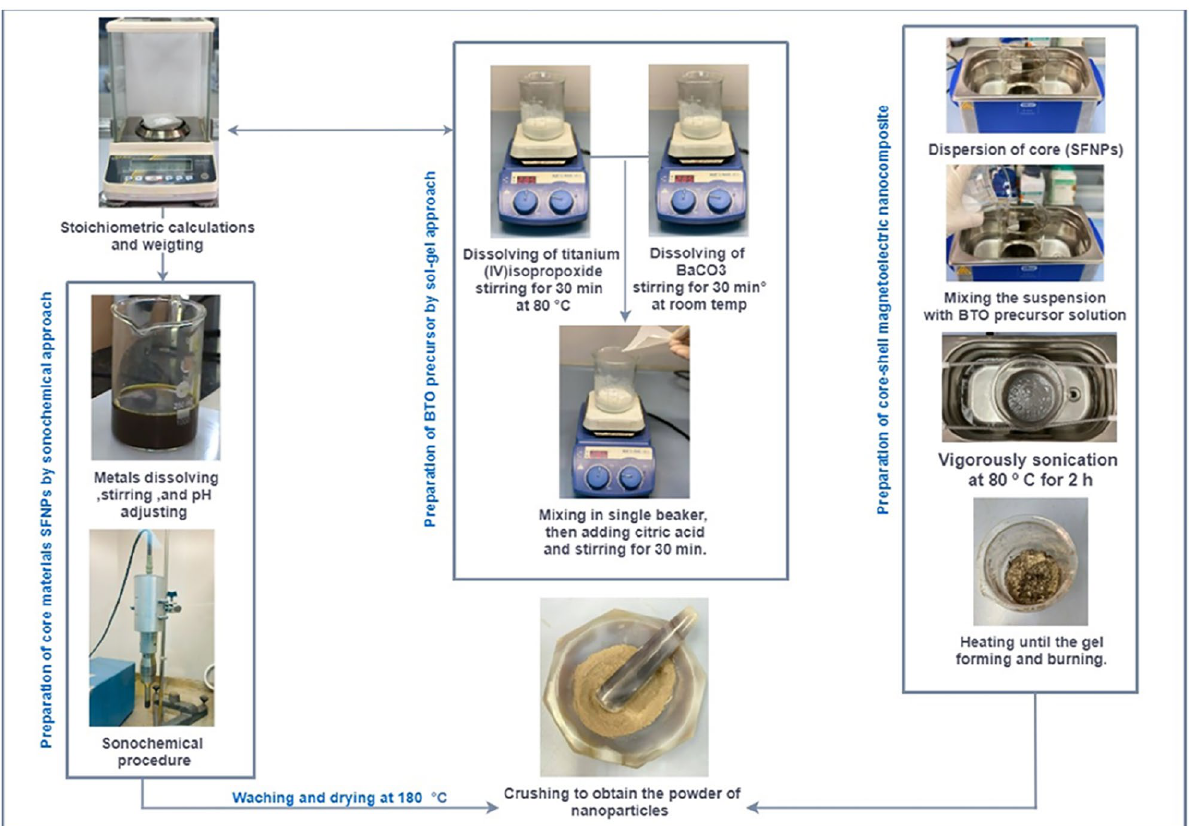
Figure 13. The experimental procedure scheme for MNPs and MENCs preparation